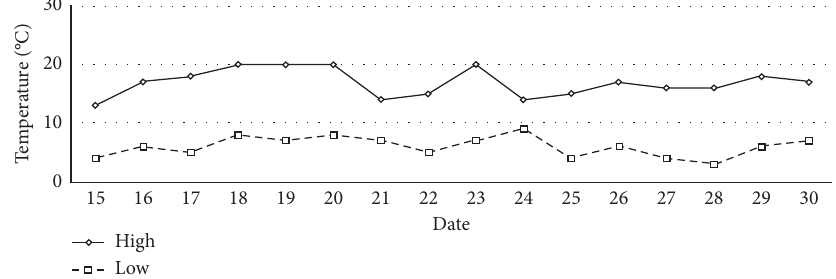
Figure 1: Temperature distribution in April from 2012 to 2014 at Harbin City.